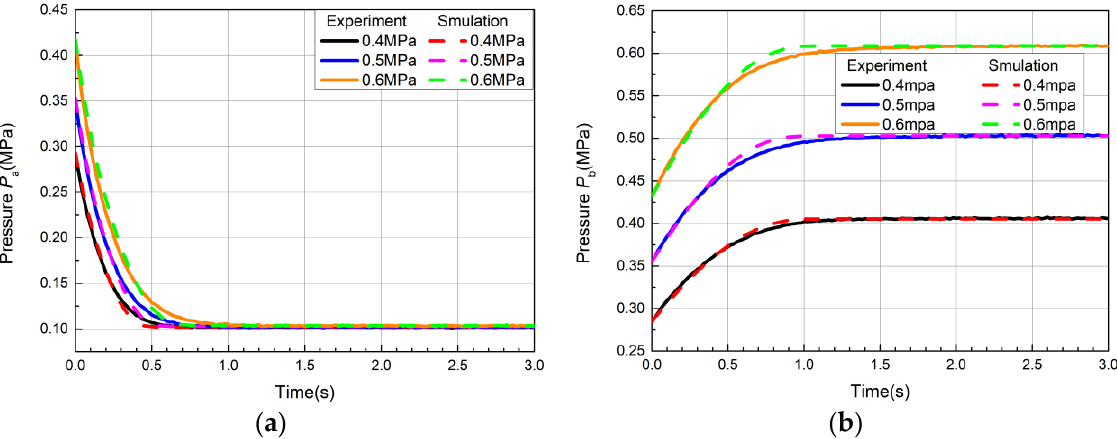
Figure 18. Filling simulation and experimental diagram of fixed chamber: ( a ) Chamber A deflating;